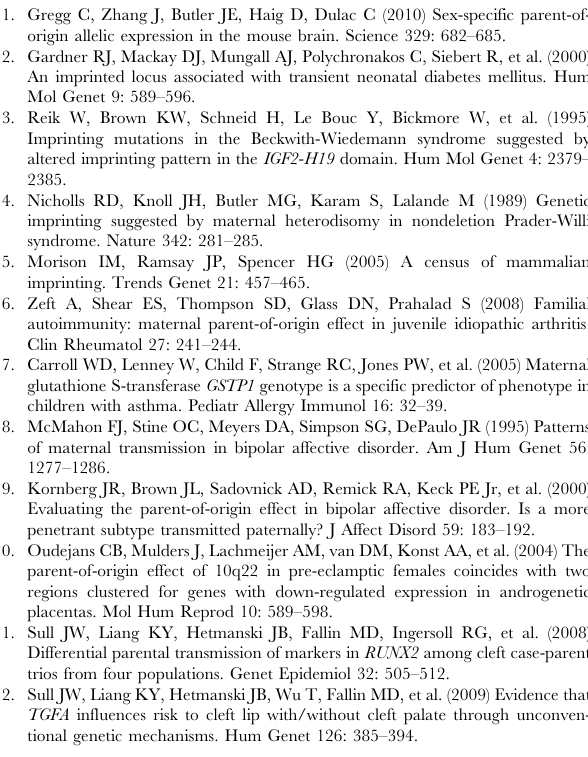
Figure S1 Flowchart showing data filtering for SNP genotype and Affymetrix data. After quality filtering for SNPs and probes, 680,475 SNPs and expression data from 92,167 probe sets were utilized from the 59 CEU and YRI trios were used for ieQTL analysis. Table S1 Results for 30 putative ieQTLs identified by cis - association analysis of gene expression levels with maternal and paternal alleles. Table S2 Results for 7 SNPs identified by comparison of expression levels between reciprocal heterozygotes. Table S3 Results for 42 cis -eQTLs identified using the Likelihood Ratio Test